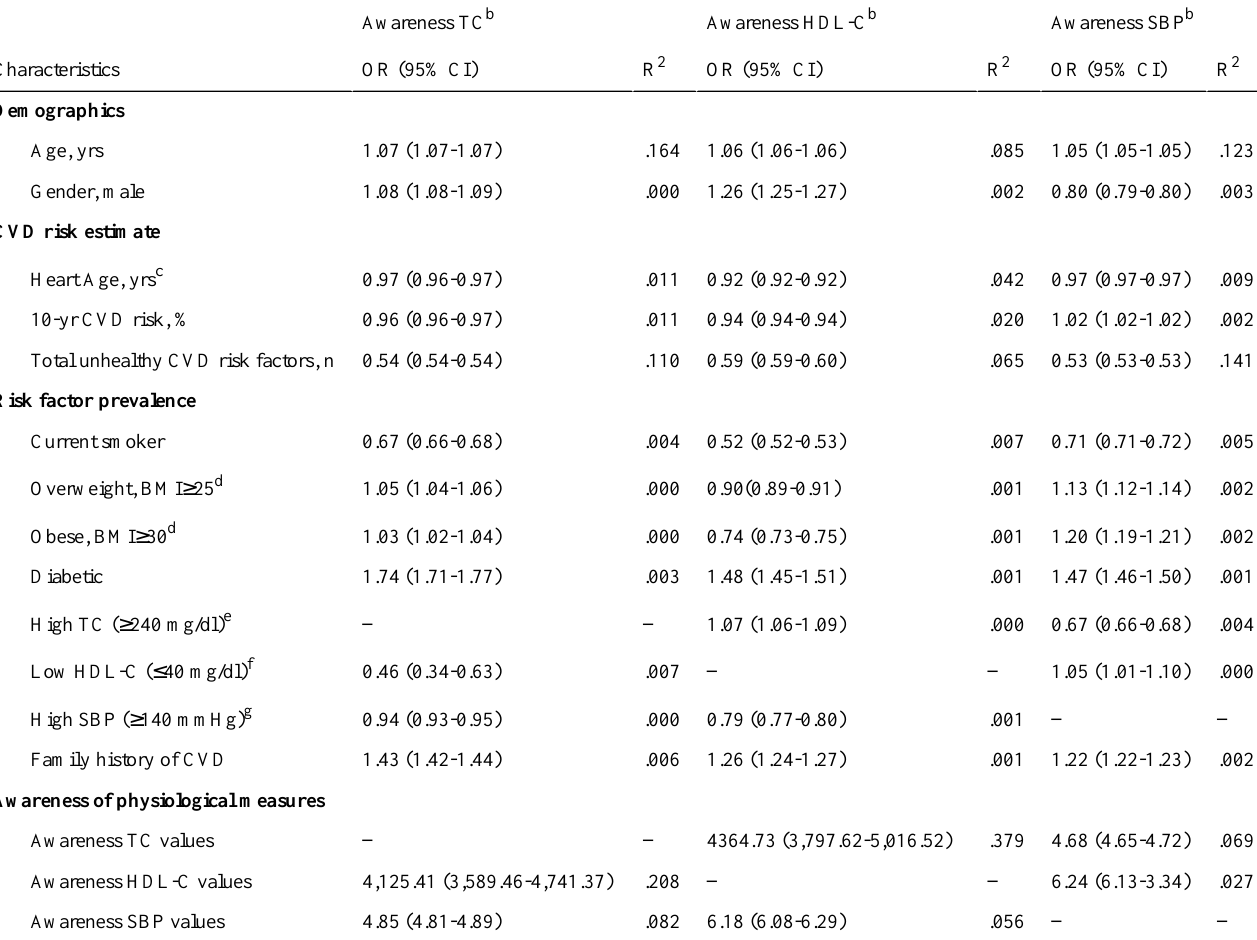
Table 2. Adjusted logistic regression examining the relations between users’ characteristics and their awareness of TC, HDL-C, and SBP values (N=2,744,091) a